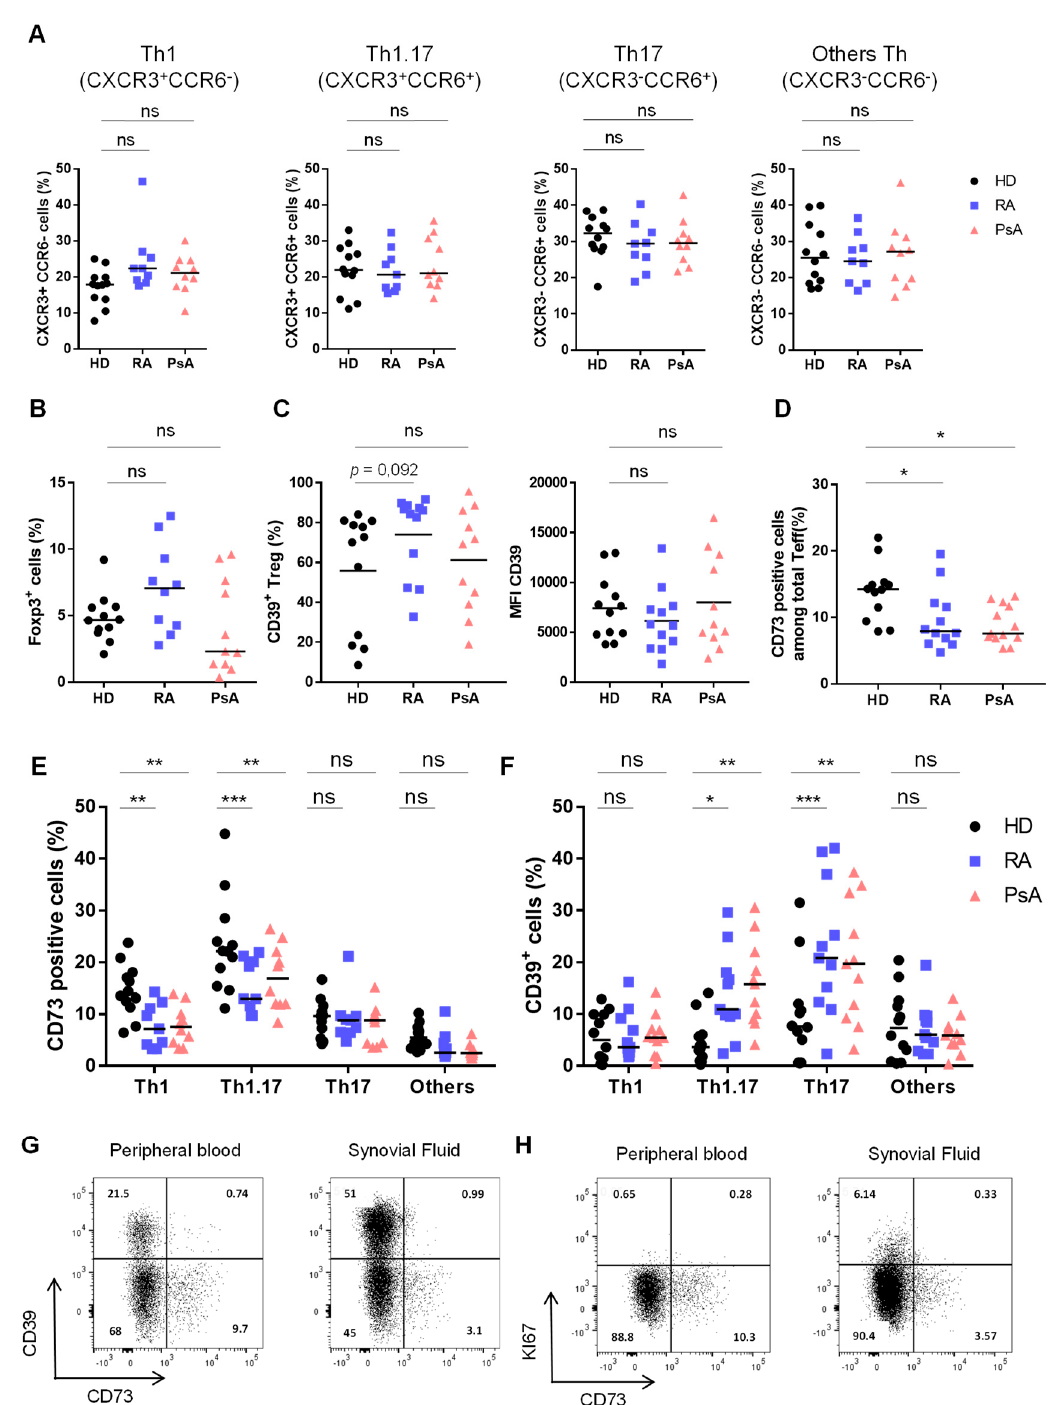
Figure 1. Unchanged Th populations but impaired CD73 expression on Th1 and Th1.17 from RA and PsA patients. ( A ). Th subsets frequencies based on phenotypic analysis (CXCR3 / CCR6 staining) among memory CD4 + T cells. ( B ). Frequencies of FoxP3 + Treg among memory CD4 + T cells. ( C ). Frequencies (left) and MFI (right) of CD39 + Treg among memory CD4 + T cells. ( D ). CD73 expression on total Te ff . ( E ). CD73 expression by Th subsets. ( F ). CD39 expression by Th subsets. (from A to F: analyses performed on peripheral blood). ( G , H ). Flow cytometry plots on total Te ff in peripheral blood and SF of an untreated RA patient showing CD73 / CD39 ( G ) and CD73 / Ki67 ( H ) staining. ( A – D ): Kruskal-Wallis test, ( E , F ): ANOVA-2. * p < 0.05, ** p < 0.001, *** p < 0.0001.